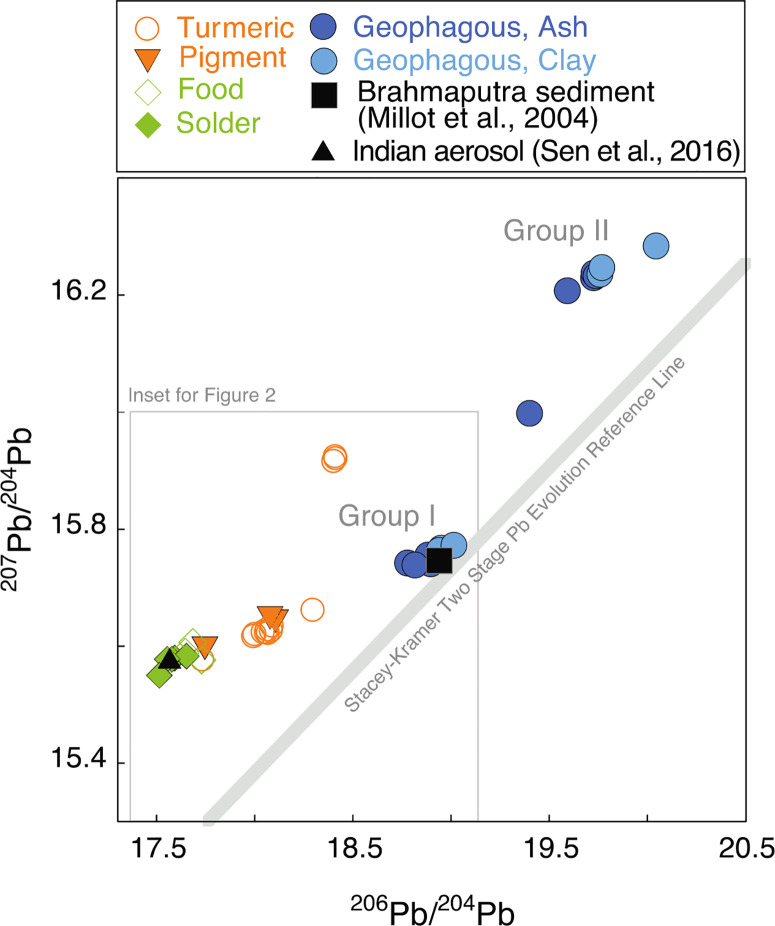
Comparison of isotope ratios (207Pb/204Pb vs 206Pb/204Pb) in Pb-soldered cans, food from Pb-soldered cans, ash, clay, turmeric, and yellow pigment collected from study participants and surrounding markets in Tangail, Mymensingh, and Kishoreganj, Bangladesh, 2015−2017. Representative reference values are shown for sediment from the Brahmaputra headwaters45 and for industrial aerosol from nearby Kanpur, northern India.43 The two-stage Pb evolution model, the 3.7 Ga terrestrial isochron, is shown for ref 44. Error bars are smaller than symbols (see Table S7). Inset is shown in Figure 2.